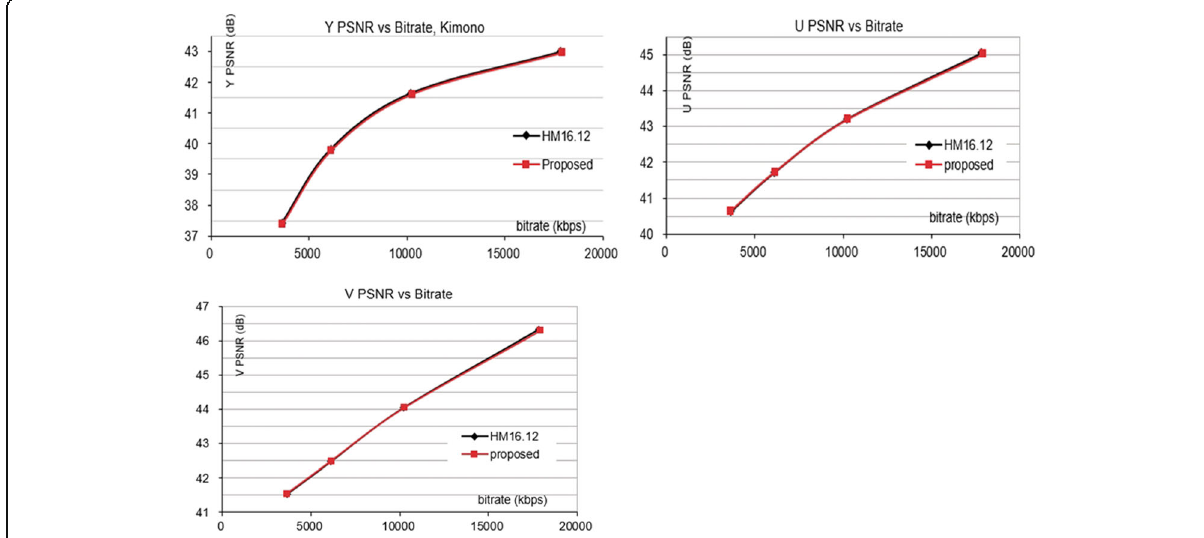
Fig. 10 RD-curves of “ Kimono ” under different QPs (22, 27, 32,